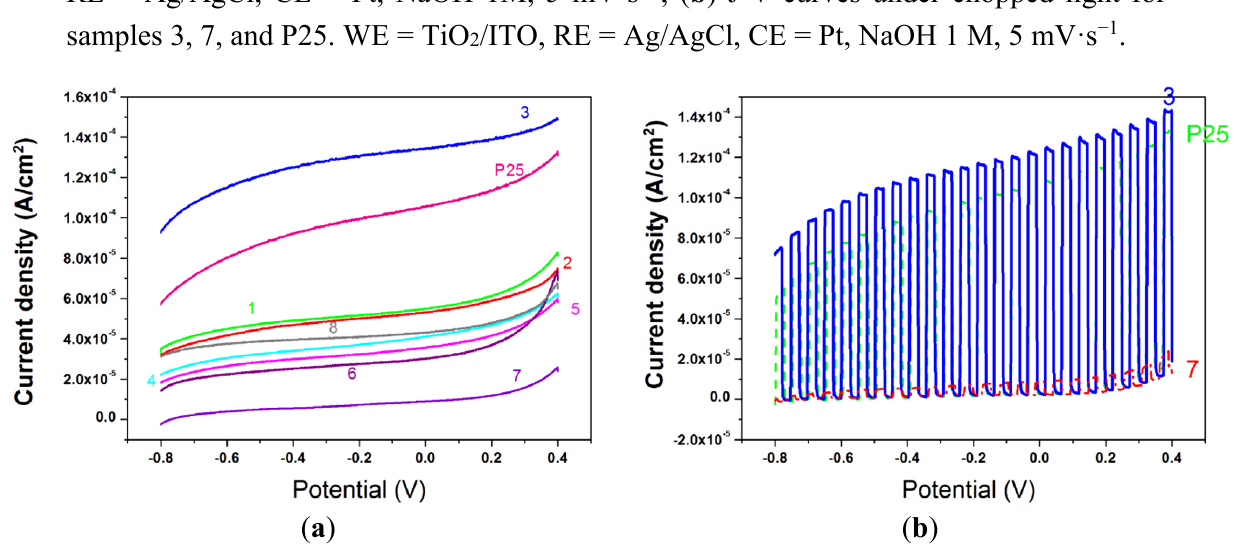
Figure 12. ( a ) J-V curves under illumination for samples 1–8 and P25. WE = TiO 2 /ITO,